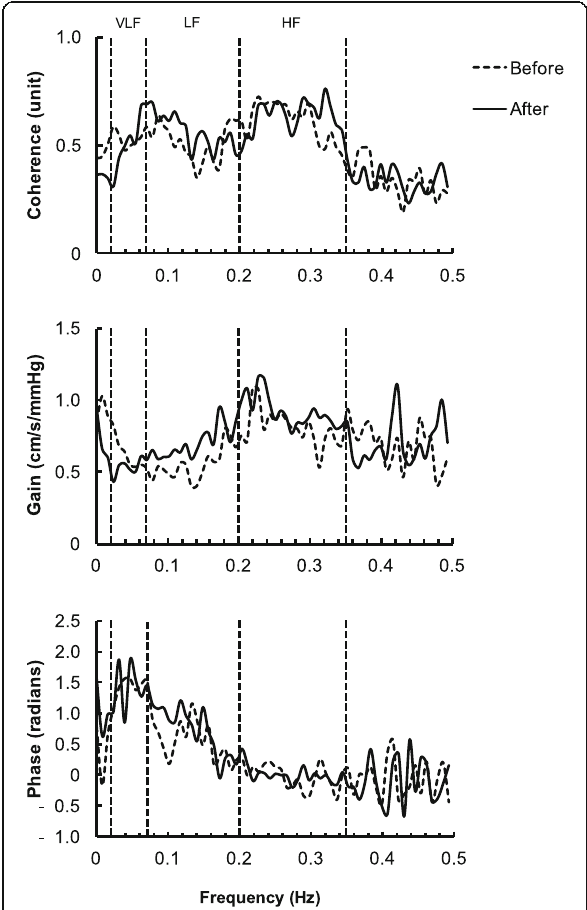
Fig. 1 Group-averaged frequency-domain analysis before and after the 14-day confinement period in an isolated environment. Coherence, coherence function; gain, transfer function gain between beat-to-beat MAP and MCBFV; phase, phase between beat-to-beat MAP, and MCBFV; VLF, very low-frequency range (0.02 – 0.07 Hz); LF, low-frequency range (0.07 – 0.20 Hz); HF, high-frequency range (0.20 – 0.35 Hz)